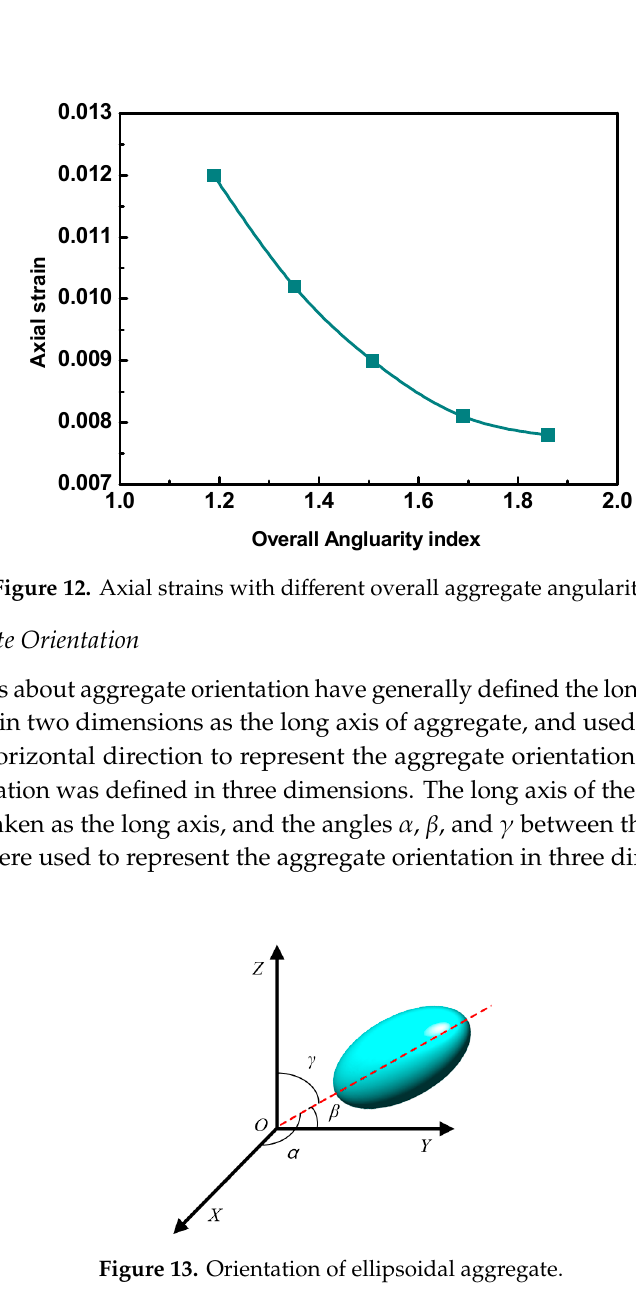
Figure 13. Orientation of ellipsoidal aggregate.